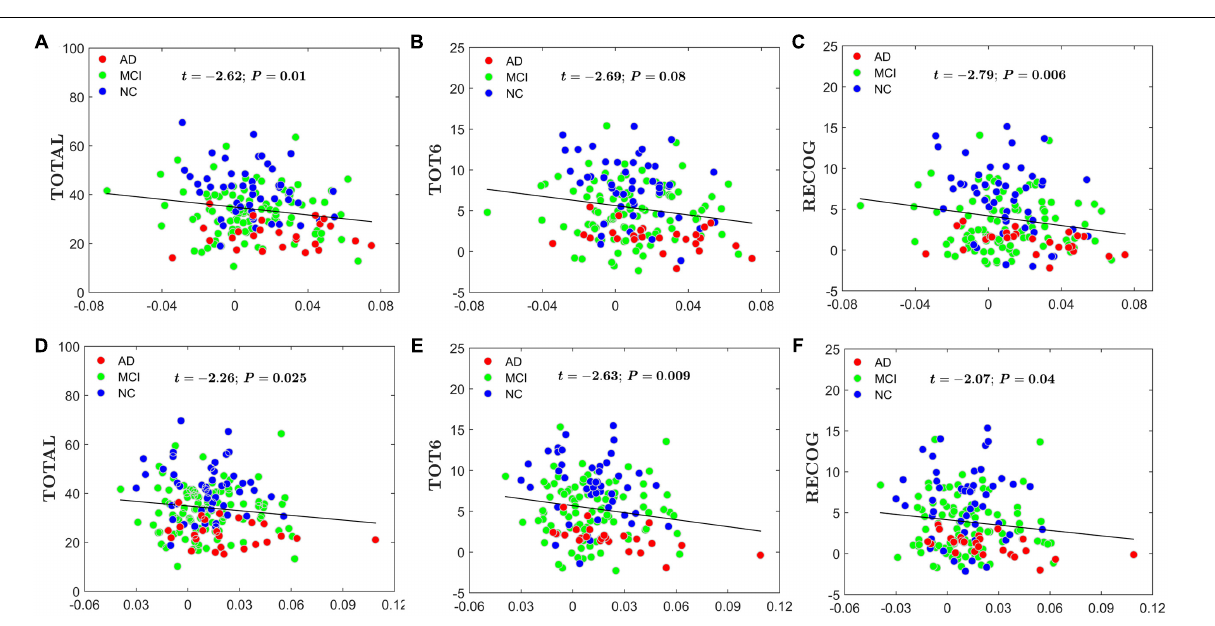
FIGURE 8 | Scatter plots of the AI of the global network and local network efficiency and RAVLT-related scores. The red circles represent AD patients; the green circles represent MCI patients; the blue circles represent NC subjects. (A) The significant correlations between the AI of the global network efficiency and TOTAL. (B) The significant correlations between the AI of the global network efficiency and TOT6. (C) The significant correlations between the AI of the global network efficiency and RECOG. (D) The significant correlations between the AI of the local network efficiency and TOTAL. (E) The significant correlations between the AI of the local network efficiency and TOT6. (F) The significant correlations between the AI of the local network efficiency and